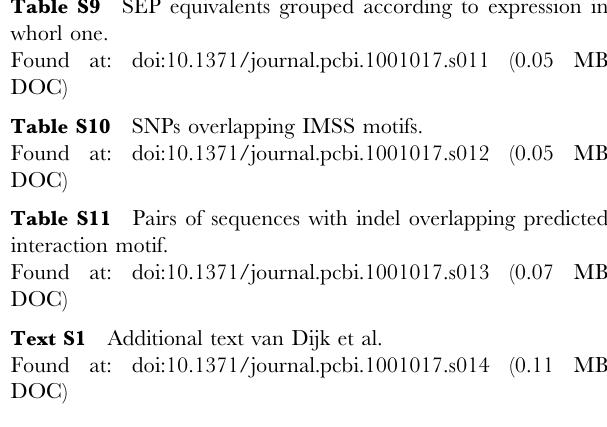
Table S6 Results yeast two-hybrid assays.